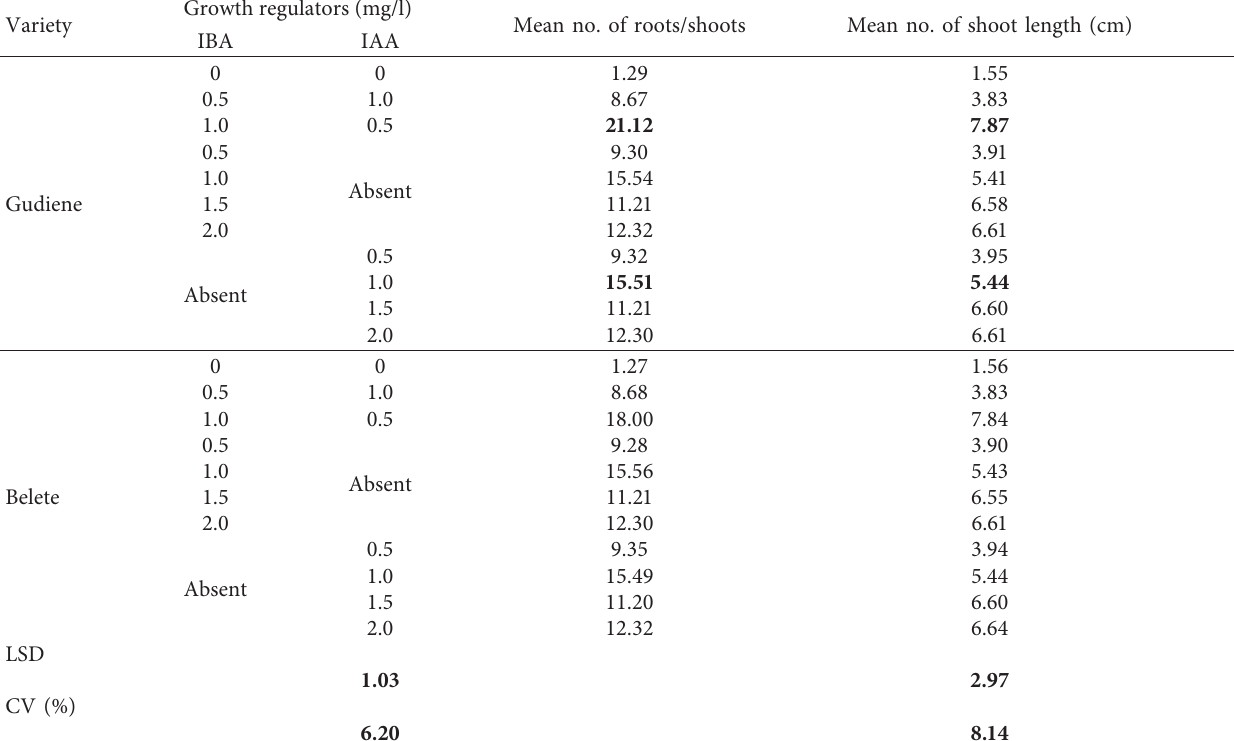
Table 3: The effect of various concentrations of IBA and IAA on in vitro shoot multiplication in Gudiene and Belete varieties of potato. Variety